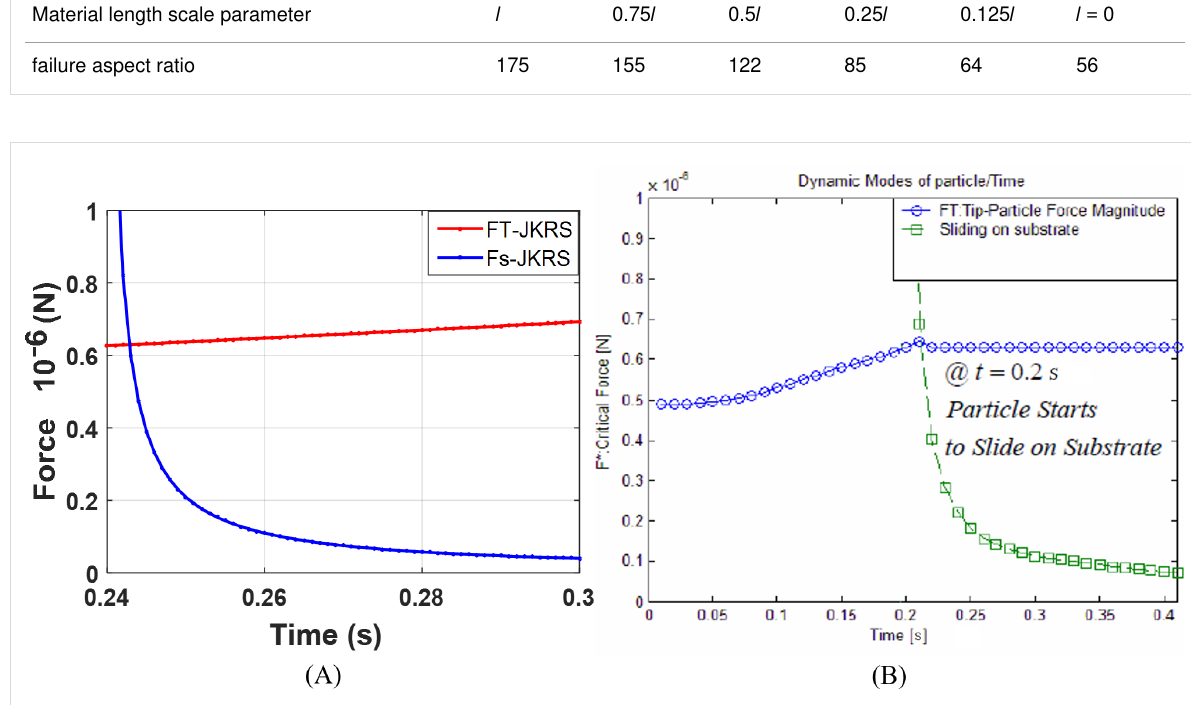
Figure 18: Comparison of the critical force and time simulation using the JKR contact model for a gold particle. A) Present study simulation method. B) Tafazzoli and Sitti simulation